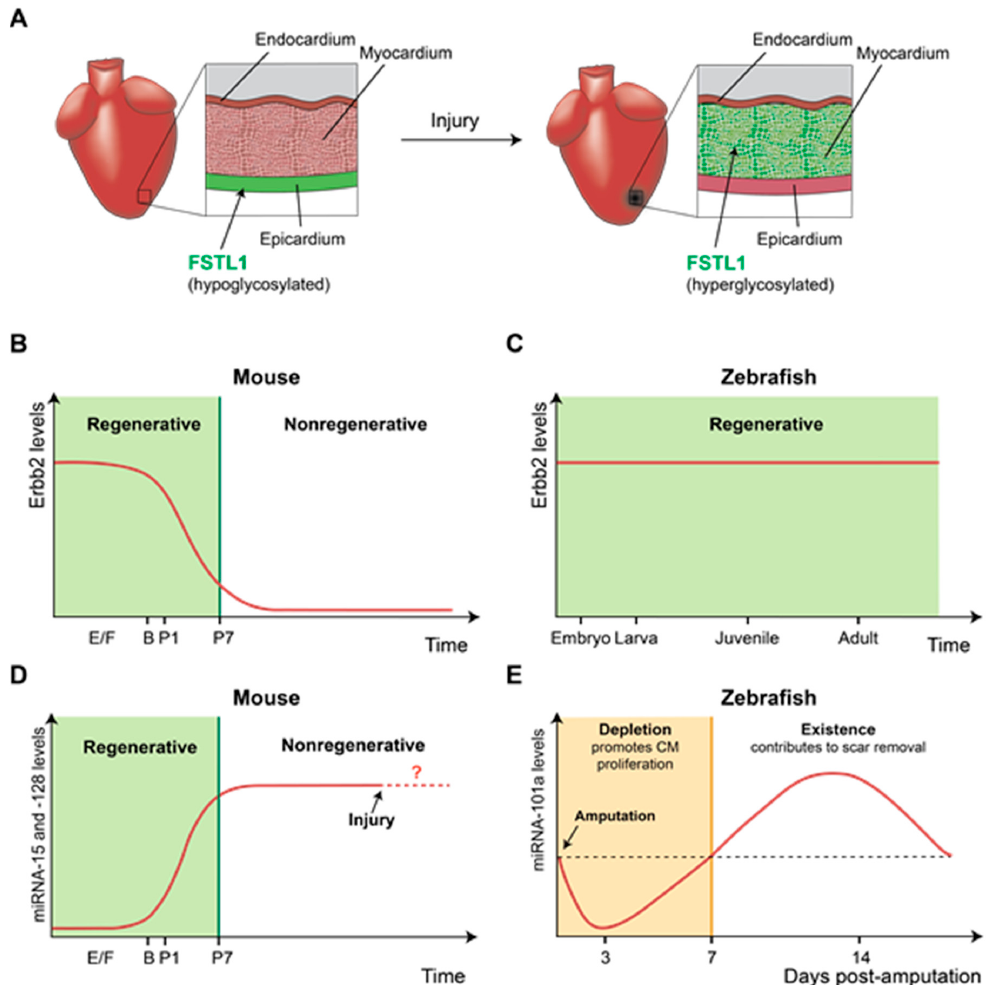
Figure 1. Differential gene expression affects regenerative ability. ( A ) Fstl1 expression in the mouse heart is altered upon injury. In uninjured hearts, the epicardium produces Fstl1 , which has the potential to promote cardiomyocyte (CM) proliferation. However, in injured hearts, Fstl1 is mainly produced by the myocardium rather than the epicardium. Fstl1 derived from the myocardium appears to be unable to promote CM proliferation due to glycosylation. ( B ) The level of Erbb2 , a receptor of Nrg1 , declines after birth, resulting in poor regenerative capacity in the mouse heart. ( C ) In zebrafish, Erbb2 expression is maintained throughout life, and a sustained Erbb2 level contributes to retaining cardiac regenerative capacity in the adult stage. ( D ) The expression level of the miRNA-15 family and miRNA-128 increases after birth in mice to inhibit heart regeneration. However, it is unclear whether expression of these miRNA is maintained upon injury. ( E ) The expression level of miRNA-101a is dynamic during heart regeneration in adult zebrafish. Depletion of miRNA-101a in the early regenerative stage promotes CM proliferation, while the presence of miRNA-101a in the late regenerative stage contributes to scar tissue removal. The ability to precisely modulate miRNA expression during heart regeneration enables zebrafish to retain remarkable regenerative capacity. In ( B , D ): E/F, embryonic/fetal period; B, birth; P, postnatal period. Adult zebrafish hearts also express inhibitory miRNAs, such as miR-101a and miR-133, in uninjured hearts [25,26]. Cardiac miR-101a expression is profoundly reduced in response to cardiac injury and steadily declines until 3 days post-amputation (dpa), when CMs dedifferentiate and start to proliferate. Subsequently, miR-101a expression significantly increases above the level of uninjured